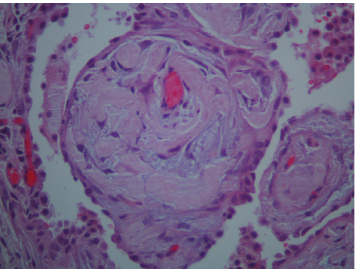
Figure 4: Pulmonary endothelial lined small vascular structure surrounded by amyloid deposits and marginated by a rim of reactive Type II pneumocytes (H&E,